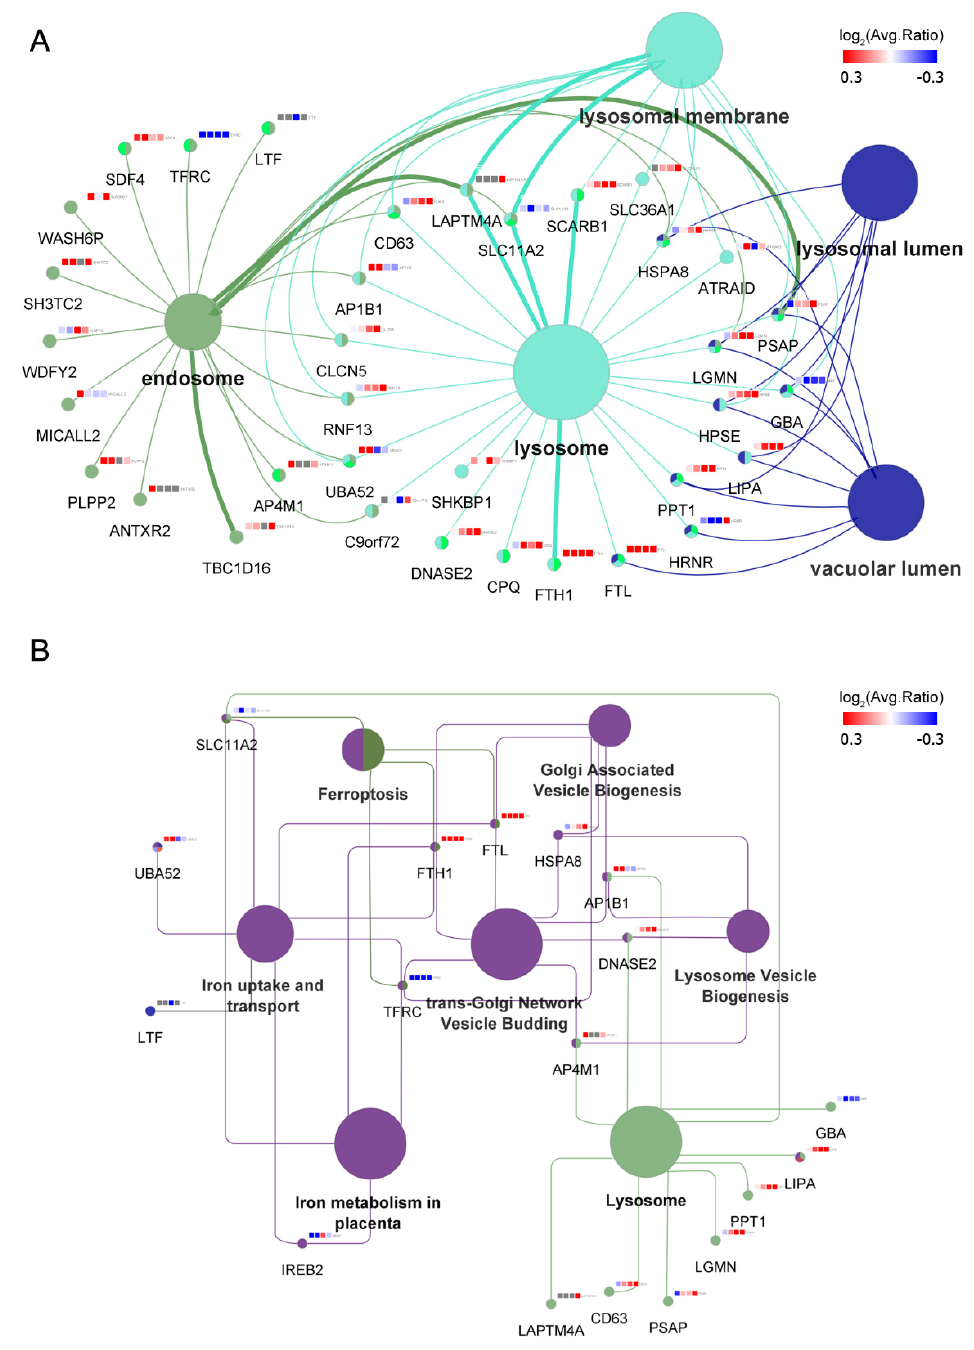
Figure 5. Bioinformatic enrichment analyses of differentially expressed proteins of MAG-treated ECs. Each protein is represented by a gene name, with the superscript color on gene name showing the protein expression ratio at days 1, 4, 7, and 10 (red, upregulated; blue, downregulated). ( A ) Network showing the enriched cellular component terms ( p -value < 0.05) related to endosome and lysosome. Enriched terms were obtained from the GO Cellular Component database. The p -value and details of every enriched term are listed in Supplementary Table S7. ( B ) Network showing the enriched function and pathway terms ( p -value < 0.05) related to iron metabolism and lysosome. Enriched terms were obtained from four databases (KEGG pathways, GO Molecular Function, Wiki Pathways, and REACTOME Pathways). The p -value and details of every enriched term are listed in Supplementary Table S8.